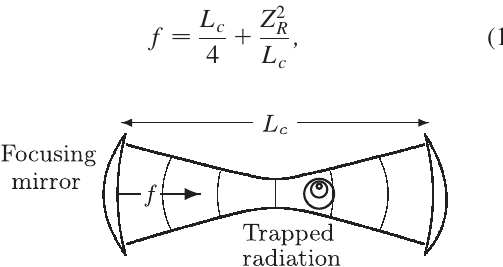
FIG. 5. Schematic of a simple two-mirror resonator cavity. The transverse properties of the stable vacuum mode are nearly identical to that of the growing FEL radiation simulated in this